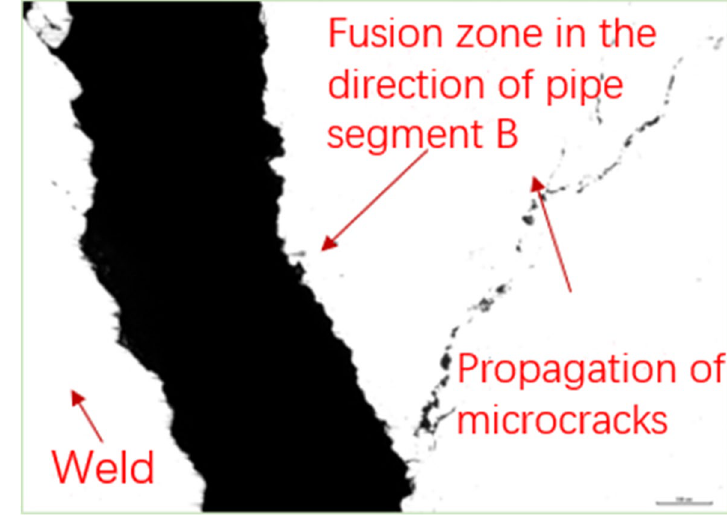
Fig. 16 Equivalent stress distribution under different operating pressure